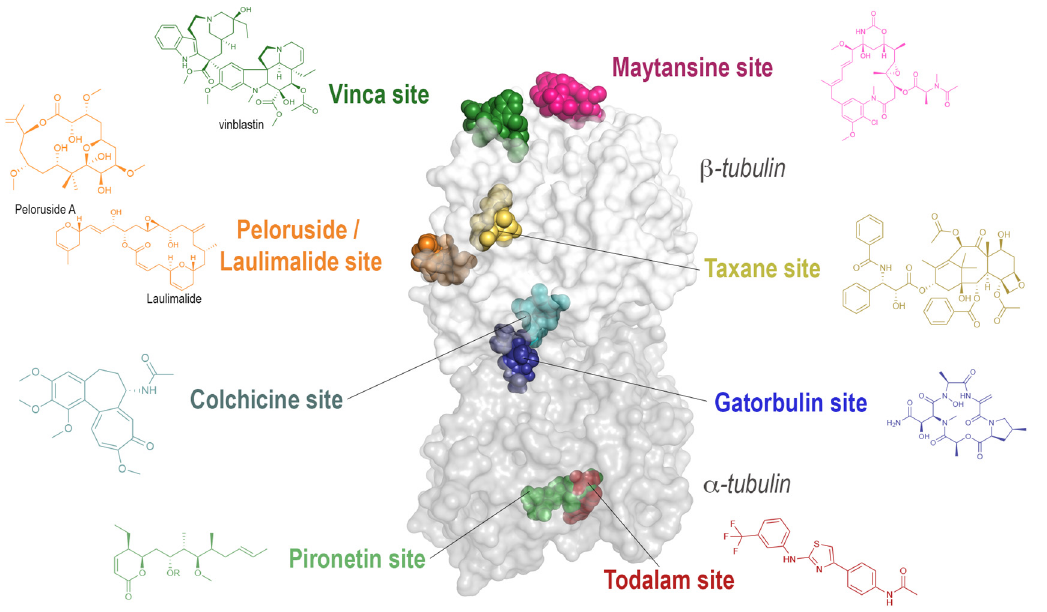
Figure 4. The eight distinct binding sites are highlighted on one tubulin dimer with all their repre- sentative ligands in colored sphere representation. The protein is shown in a transparent surface representation α - and β -tubulin chains are colored dark and light grey, respectively. The chemical structures of the ligands after which the binding sites were named are indicated next to the labels and colored following the color code of their sphere model.